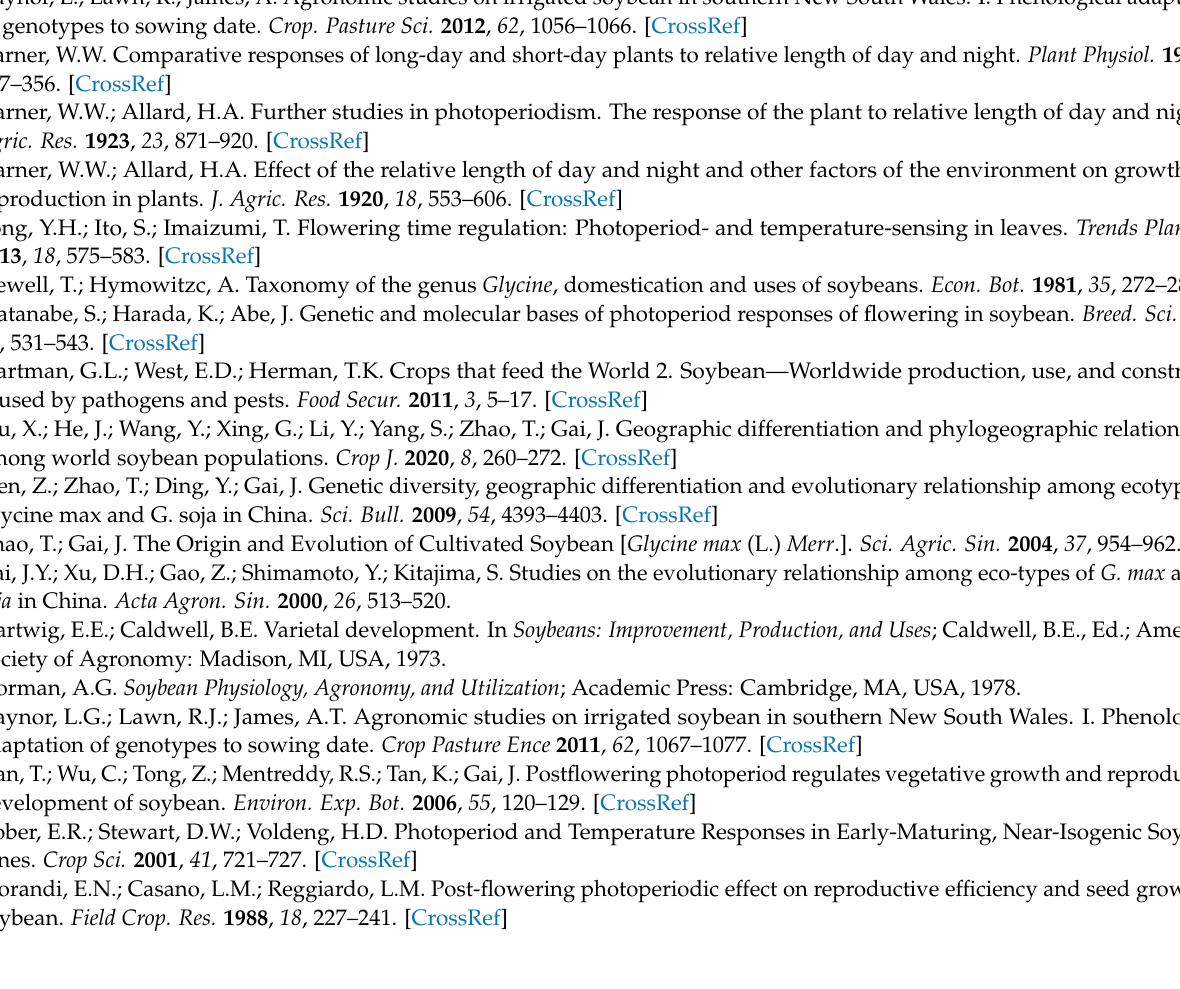
Population (WSGP). Table S4: Regression analysis of variance of growth period traits, accumulative day length and accumulative active temperature. Table S5: Estimation of parameters in regression of growth period traits on accumulative day length and accumulative active temperature. Table S6: Variation of growth period traits, accumulative day length and accumulative active temperature in genetic clusters of the World Soybean Germplasm Population